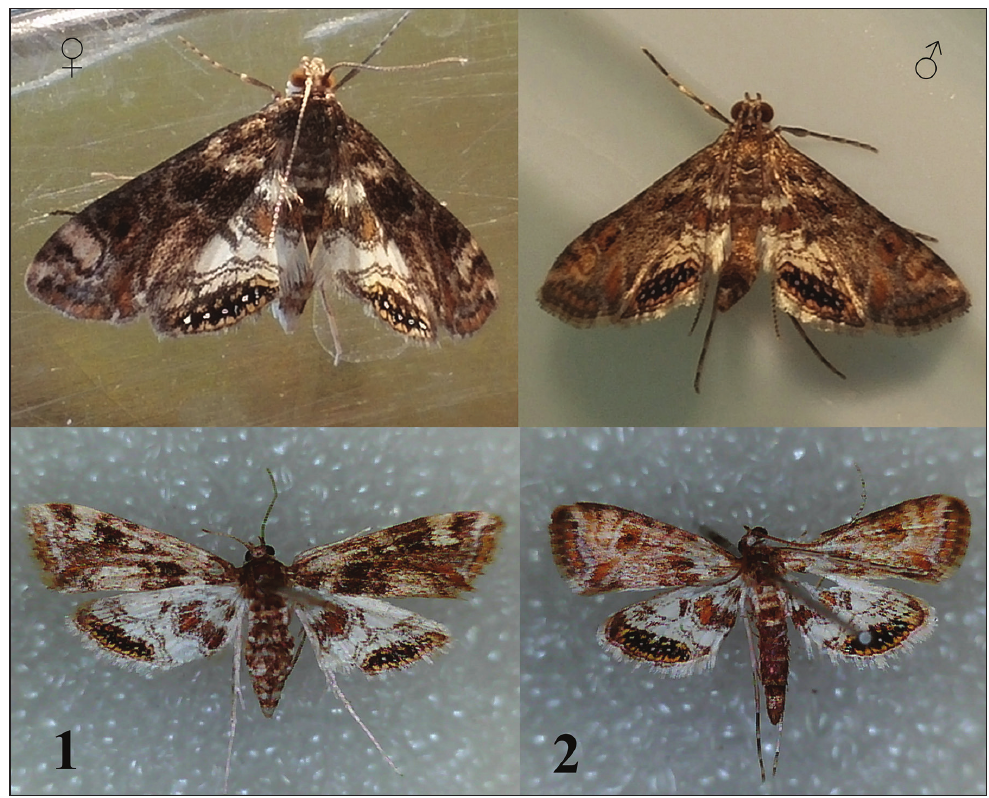
Figures 1–2. Cataclysta lemnata adults. 1. Female; 2. Male (live specimens above and prepared specimens